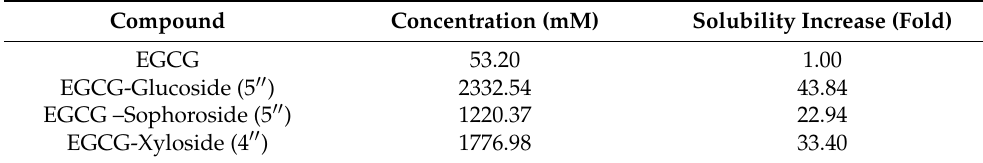
Table 2. Solubility determined for EGCG and its glycosylated derivatives.